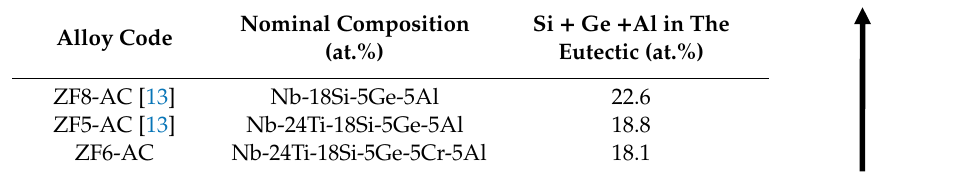
Table 9. Concentration of Si + Ge in the Nb ss + β Nb 5 Si 3 eutectic in as cast ZF series alloys. Alloy Code & Reference